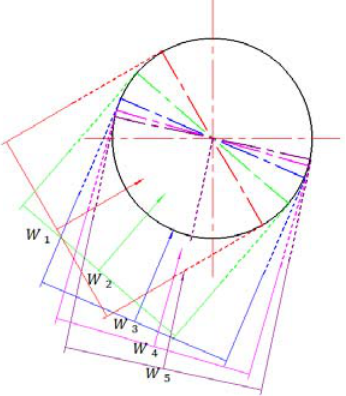
Figure 19. Variation of the direction of the relative wind speed at different rotation speeds [29].